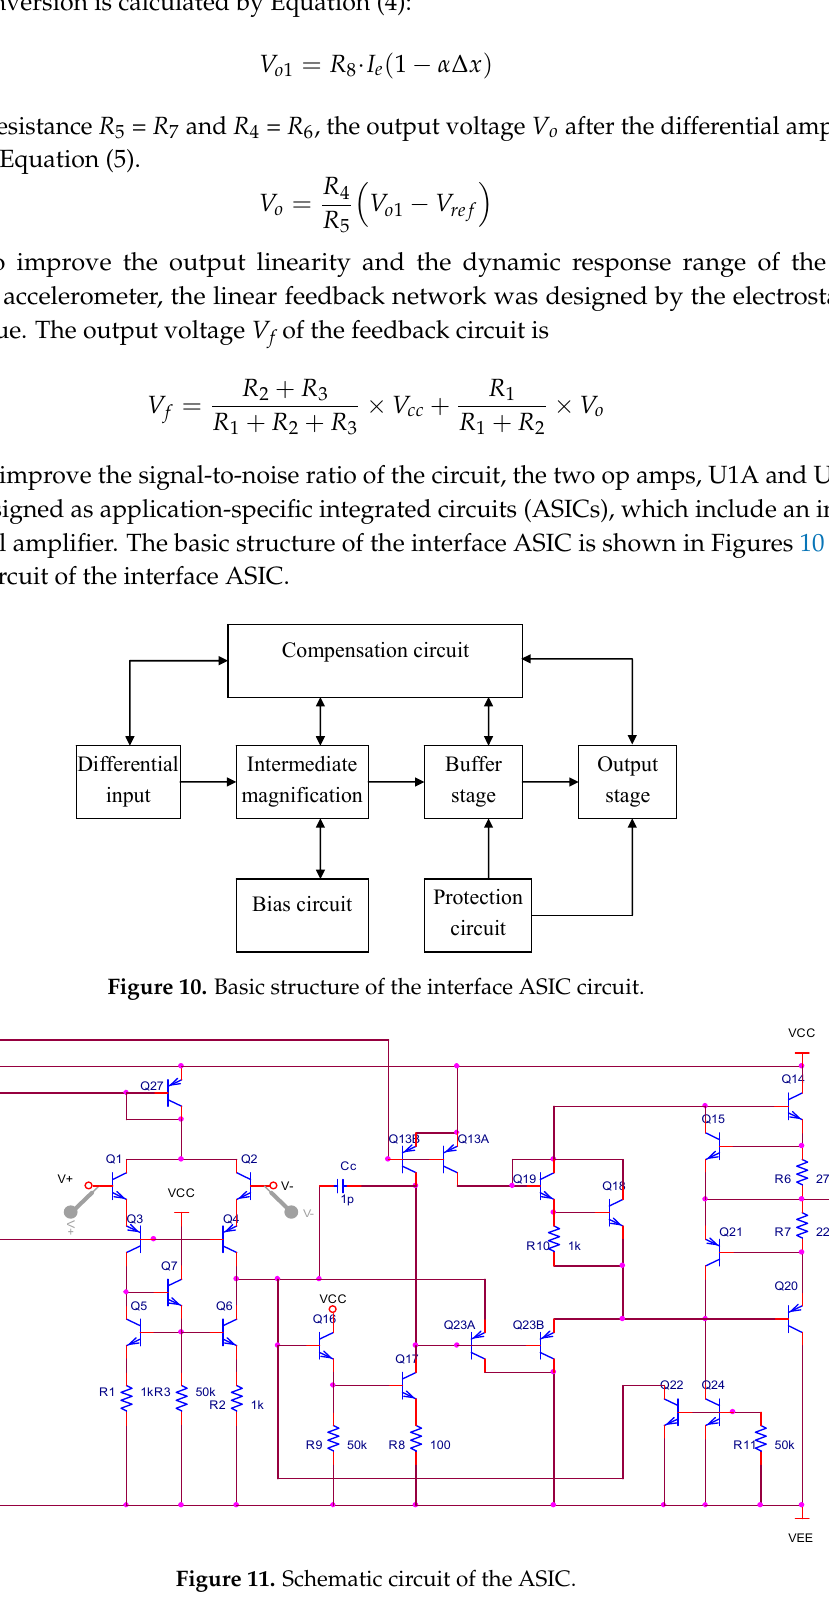
Figure 11. Schematic circuit of the ASIC.